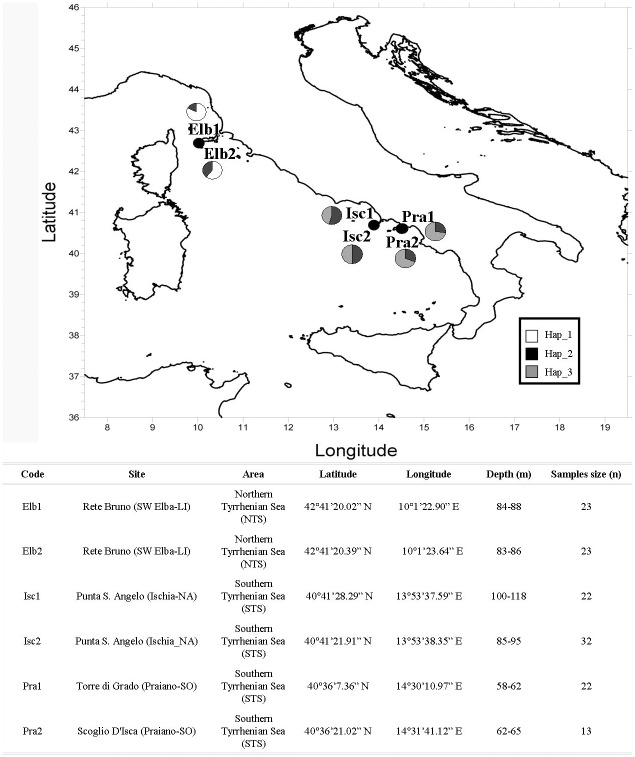
Map of the sampling sites, including a table with identification codes, sites, areas, geographical coordinates, depths and sample size.Pie charts represent mtC haplotype frequencies for each population.